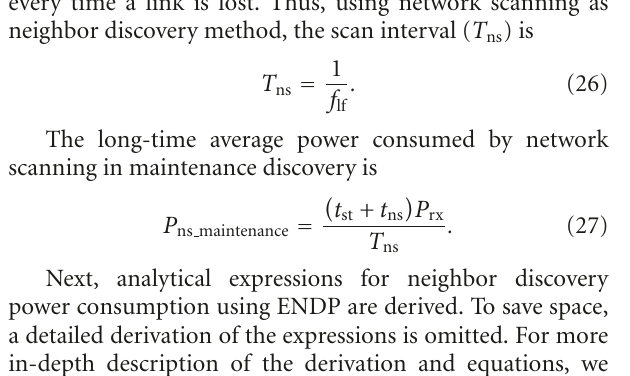
Table 2: Additional symbols, descriptions, and defined values for neighbor discovery power consumption